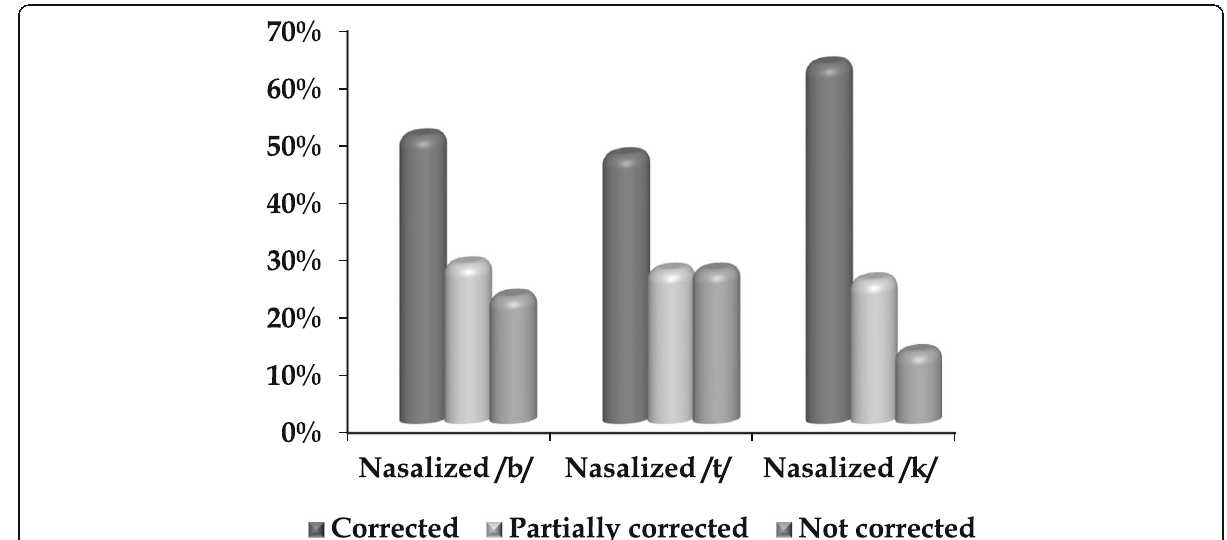
Fig. 2 Distribution of the studied cases after intervention ( n =